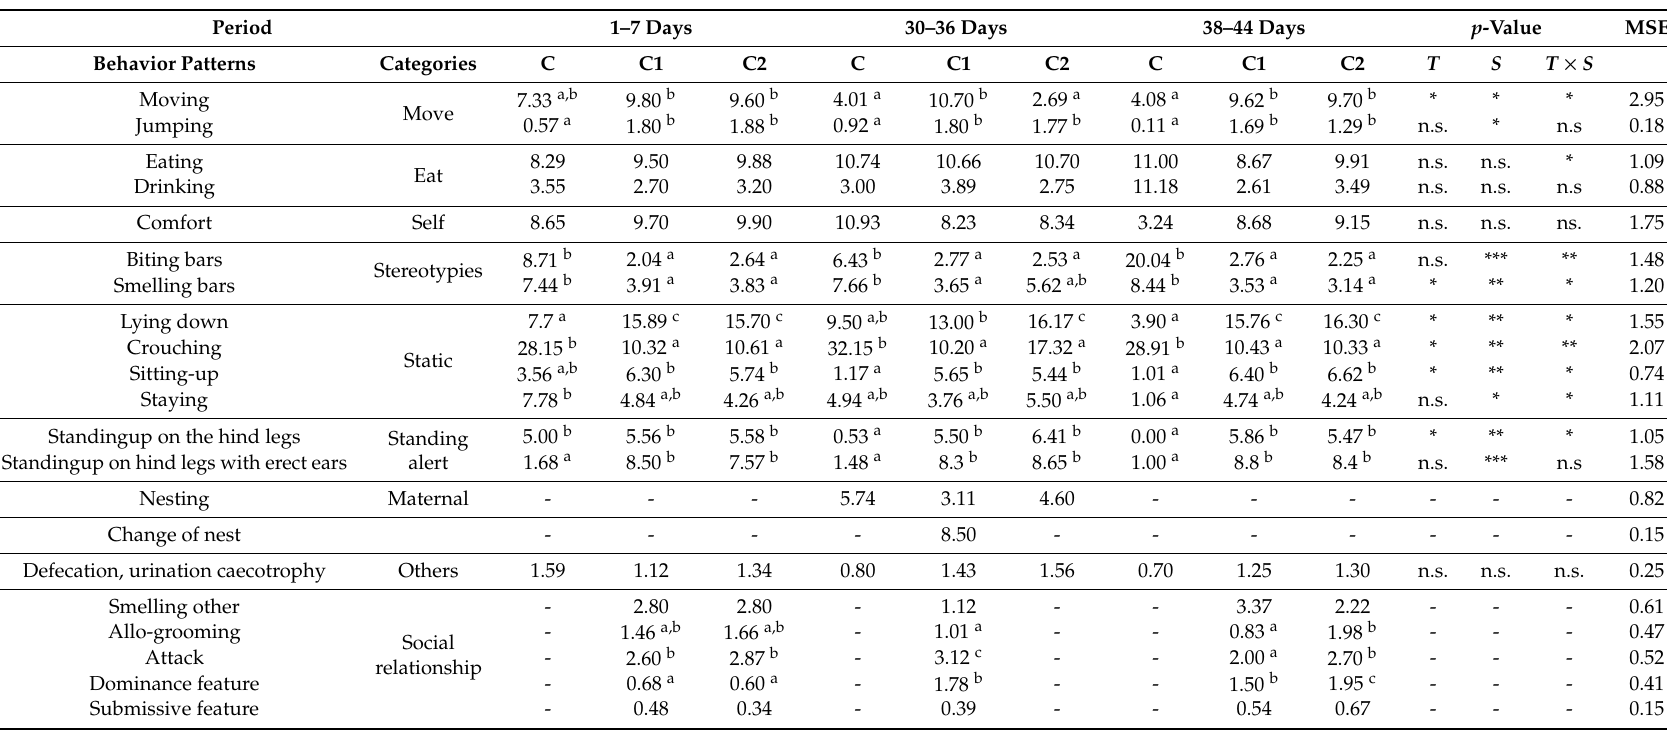
Table 2. E ff ect of housing system on percentage of behaviours (with respect to total activities) and percentage of social behaviours (with respect to total social activities) in di ff erent periods of the reproductive